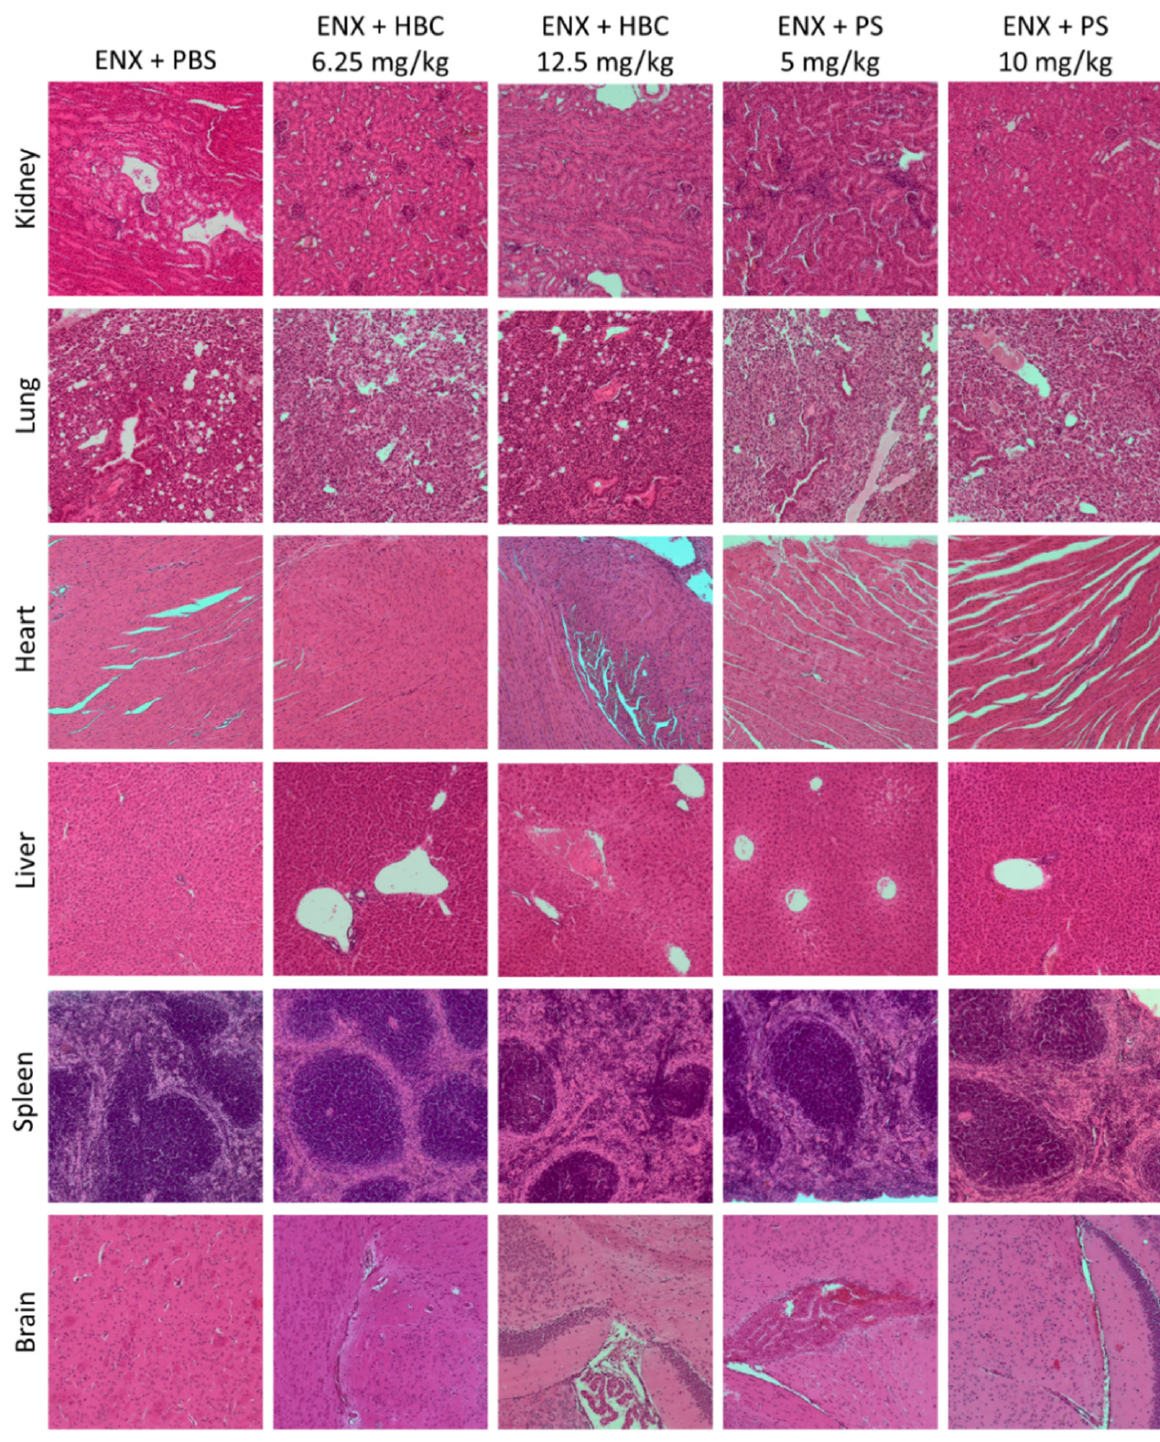
Figure 3. Representative micrographs of tissue sections of kidney, lung, heart, liver, spleen, and brain sections of mice treated subcutaneously with enoxaparin (ENX) (5 mg/kg) and an intravenous bolus of vehicle, HBC (6.25 and 12.5 mg/kg) or protamine sulfate (PS) (5 and 10 mg/kg). Organs were harvested 10 hours after antidote administration. Original magnification, 100×; hematoxylin and eosin staining. PBS, phosphate buffered saline.